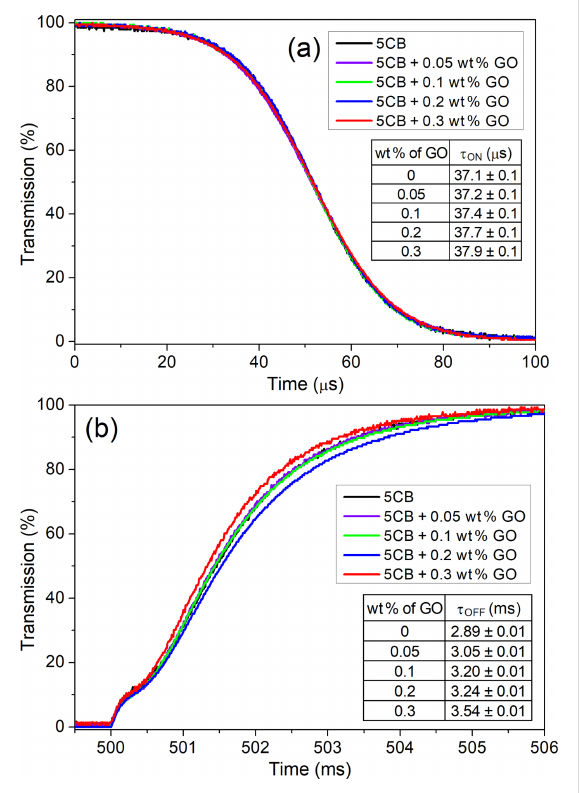
Figure 7: Electro-optical characteristics of the switching process in the cells with the 5CB-GO suspensions. Normalized light transmission as a function of time for (a) switch-on ( τ 90–10 ) and (b) switch-off ( τ 10–90 ) processes for different concentrations of GO flakes in the 5CB liquid crystal